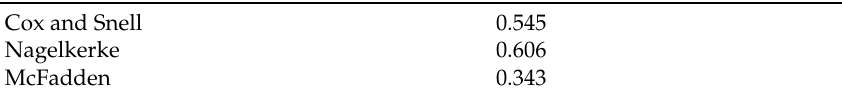
Table A3. Pseudo R-square.